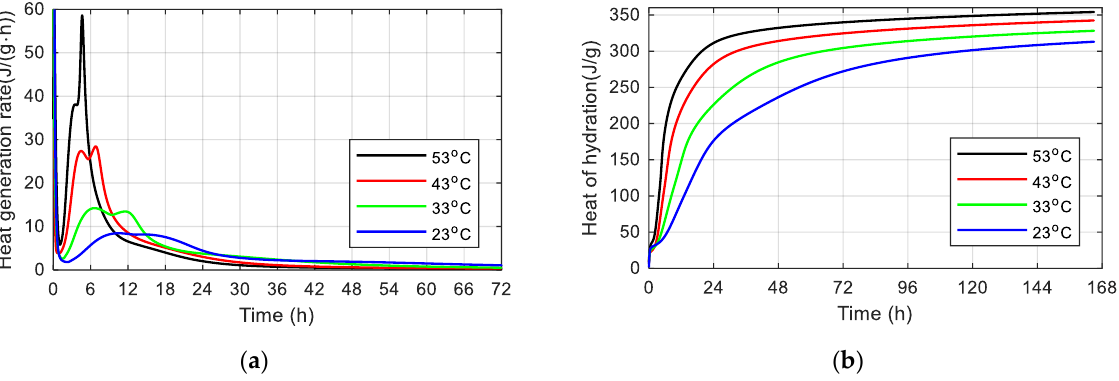
Figure 2. Results of calorimetric tests for OPC mortar mixtures: ( a ) the heat generation rate at first 72 h, ( b ) heat of hydration during 165 h.